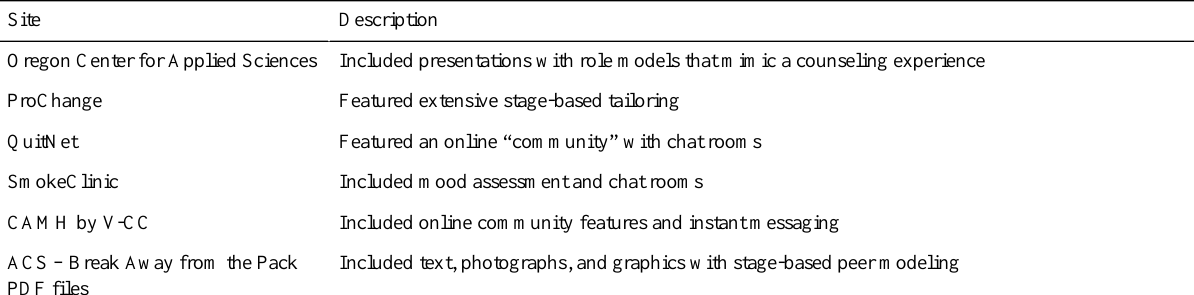
Table 1. Research sites and